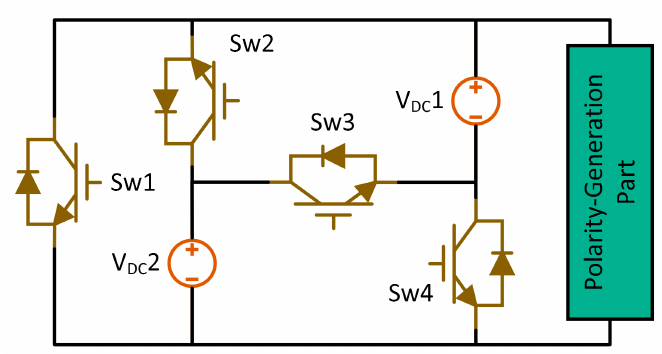
Figure 14. Topology of Nilkar multilevel inverter.